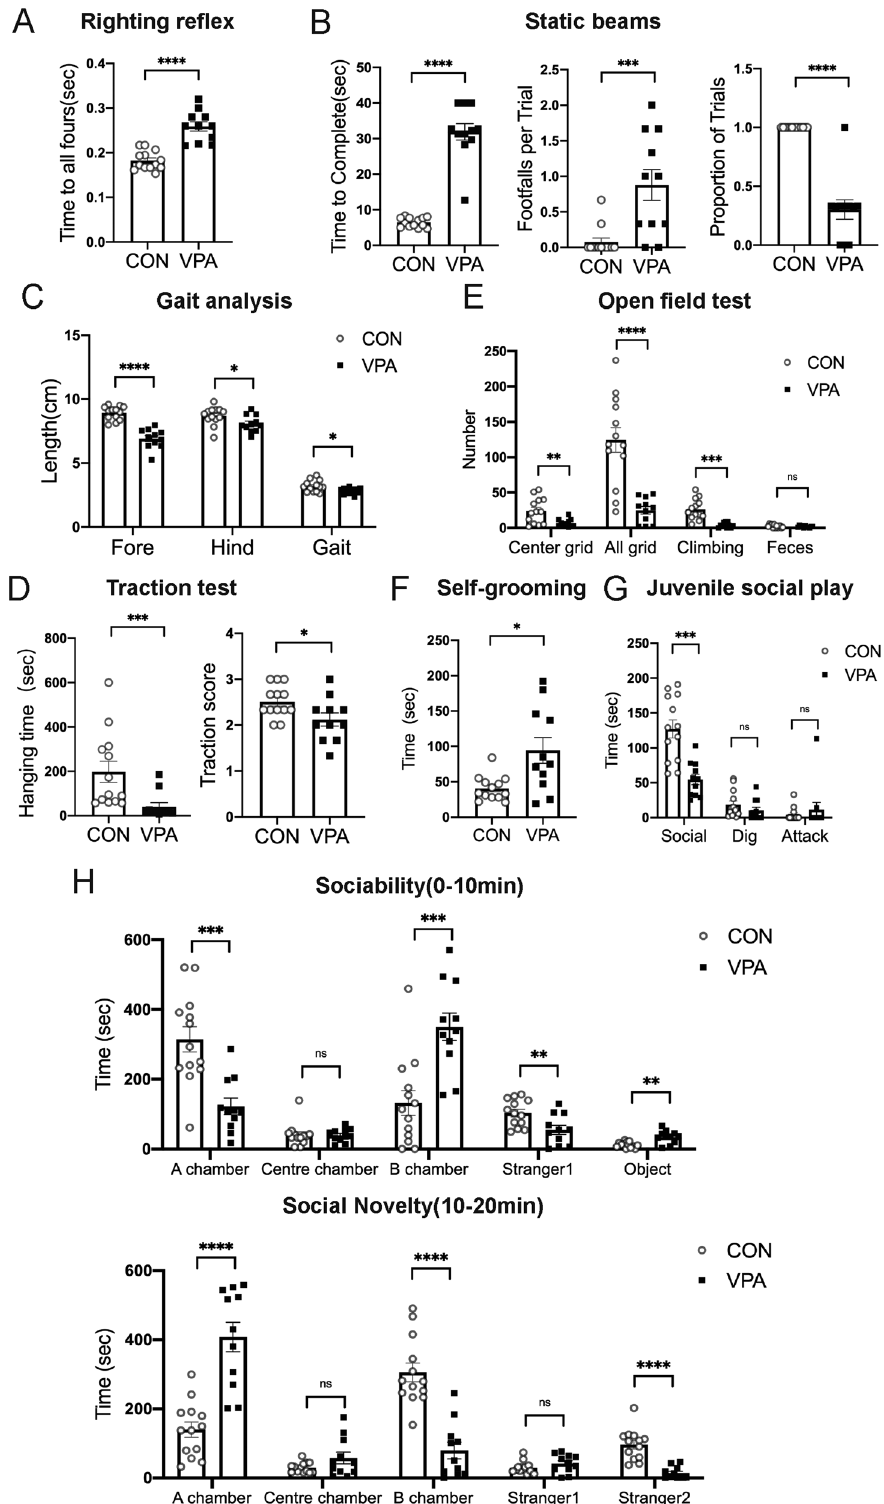
Fig. 2 Prenatal exposure to VPA induced the defection of behaviours. Cerebellum-related behaviours: righting re fl ex ( A ), static beams ( B ), gait analysis ( C ), traction test ( D ). Autism-like behaviours: open fi eld test ( E ), self-grooming test ( F ), juvenile social play ( G ), the three-chamber social test ( H ). Data are expressed as mean ± SEM. Student ’ s t -test (A, C (Fore, Hind, Gait) , D (Traction score) , E (Faeces) , G (Social) , H (10min: Stranger1, A chamber, B – Whitney test (B chamber) , H (20min: A chamber, B chamber) ); Mann (Time to Complete, Footfalls per Trial) , D( Hanging time) , G (Dig, Attack) , H (10min: Centre chamber) , H (20min: Stranger1, Stranger2) ); Welch ’ s correction (B (Proportion of Trials) , E (Centre grid, All grid, Climbing) , F, H (10min: Object) , H (20min: Centre chamber) ). (ns no signi fi cant difference, * P < 0.05, ** P < 0.01, *** P < 0.001, **** P < 0.0001, Sample sizes ( n ): n (CON) = 13, n (VPA) =